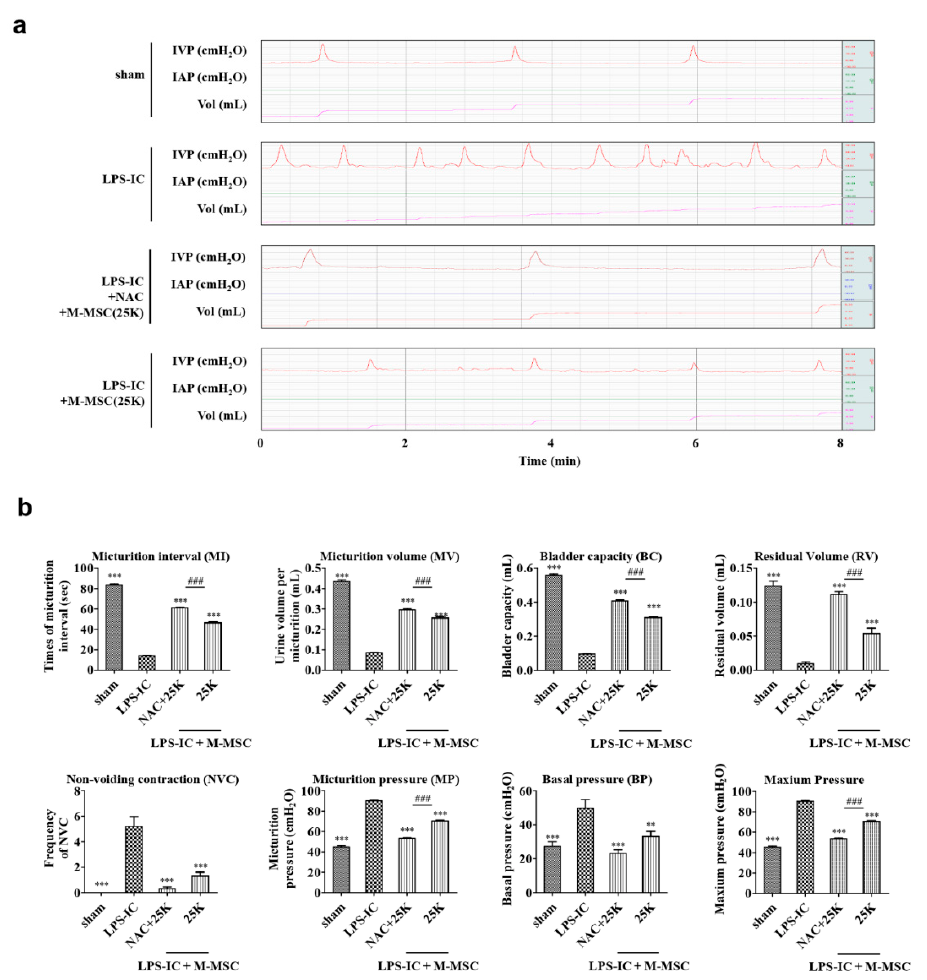
Figure 4. Injection of NAC and 25K M-MSCs ameliorated bladder voiding functions in LPS-IC rats. ( a ) Representative awake cystometry results ( b ) and quantitative bladder voiding data at one week after injection of LPS-IC rats with the indicated number of NAC and M-MSCs (25K, K = thousand). Data are presented as the mean ± SEM (five independent animals per group). * p < 0.05, ** p < 0.01, and *** p < 0.001 were compared with the LPS-IC group and # p < 0.05, ## p < 0.001, and ### p < 0.001 were compared with the NAC + 25K group according to a one-way ANOVA using the Bonferroni post-hoc test. sham: sham-operated.